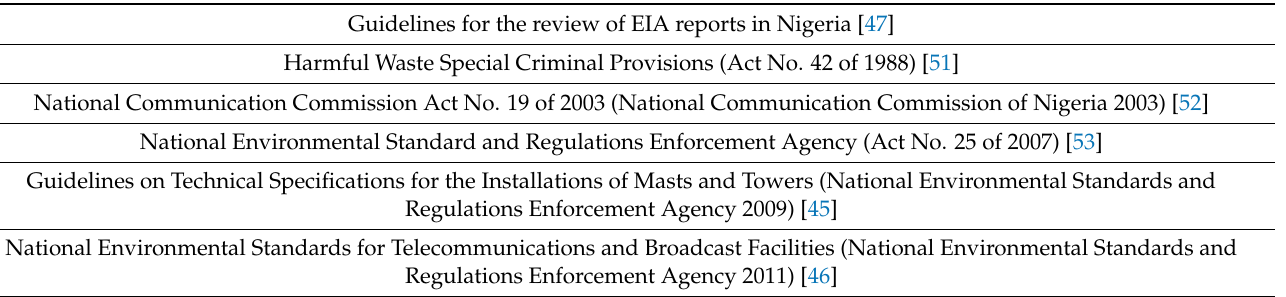
Table 1. Some of the regulations guiding infrastructural developments in the telecommunications sector of